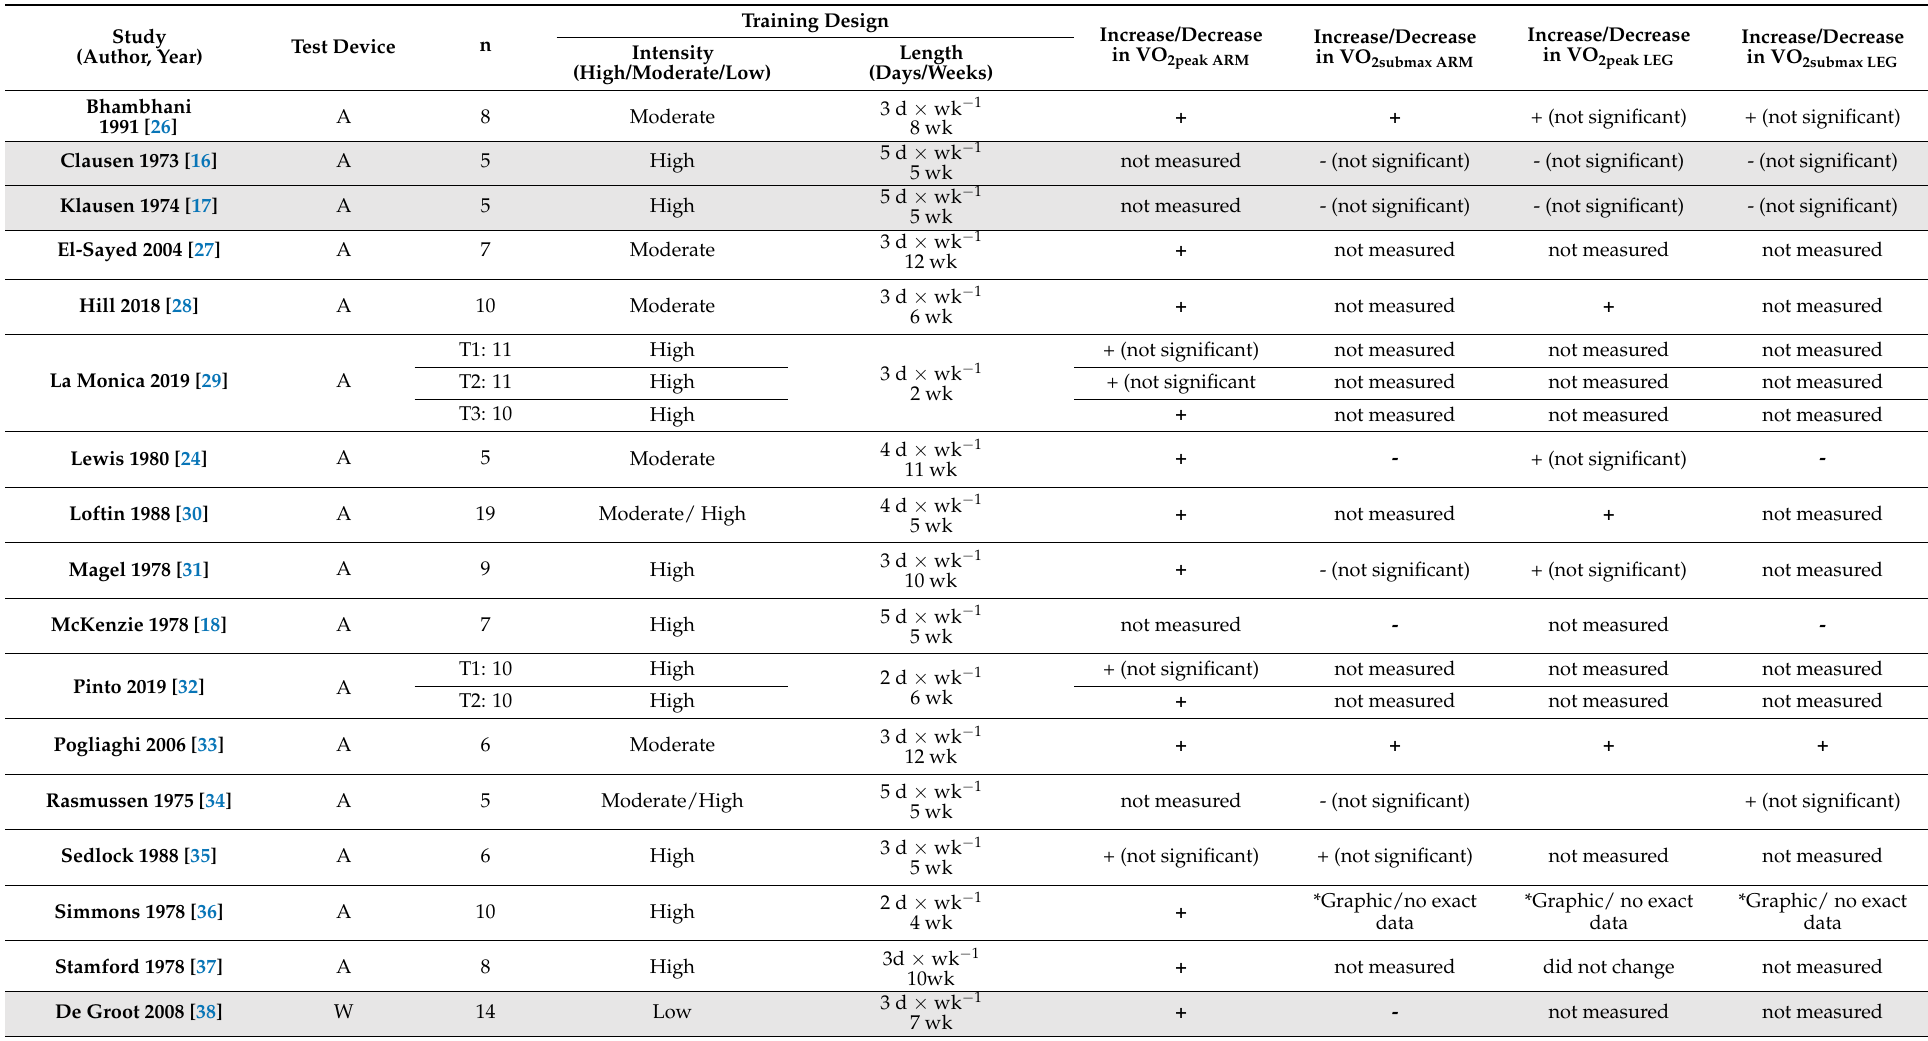
Table 8. Overview: Outcomes of